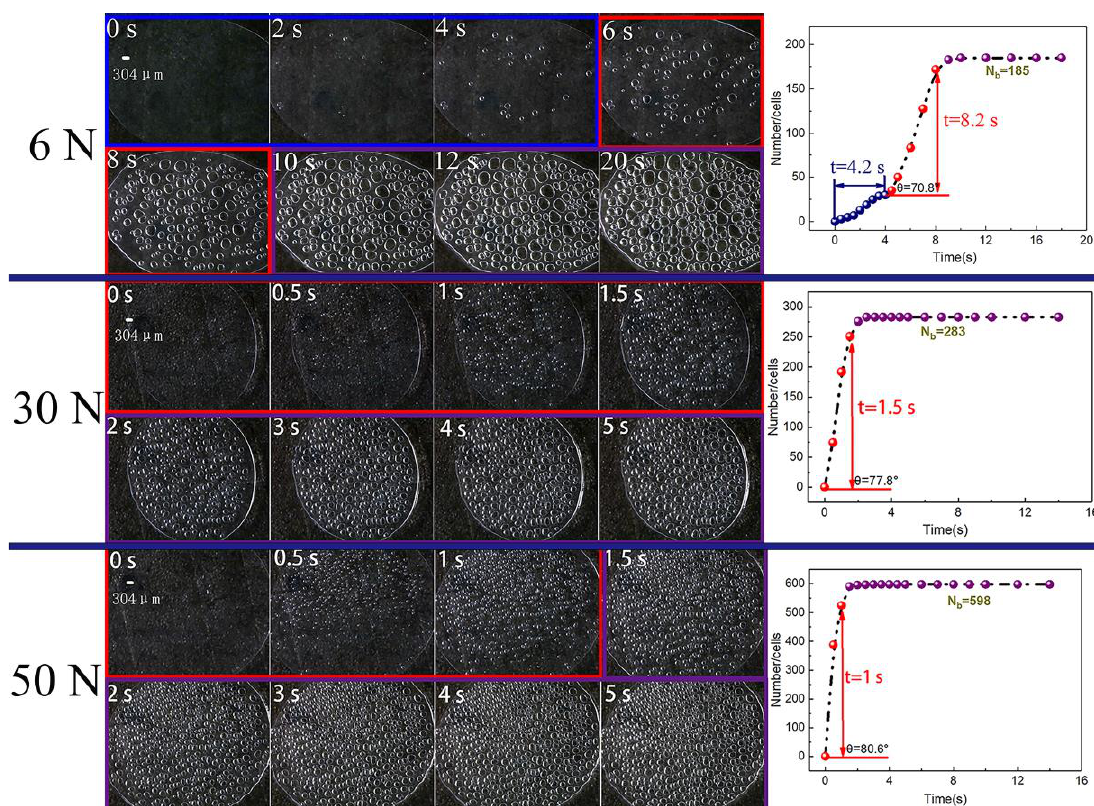
Figure 9. Video screenshots and the n - t curve at different times with different external forces.